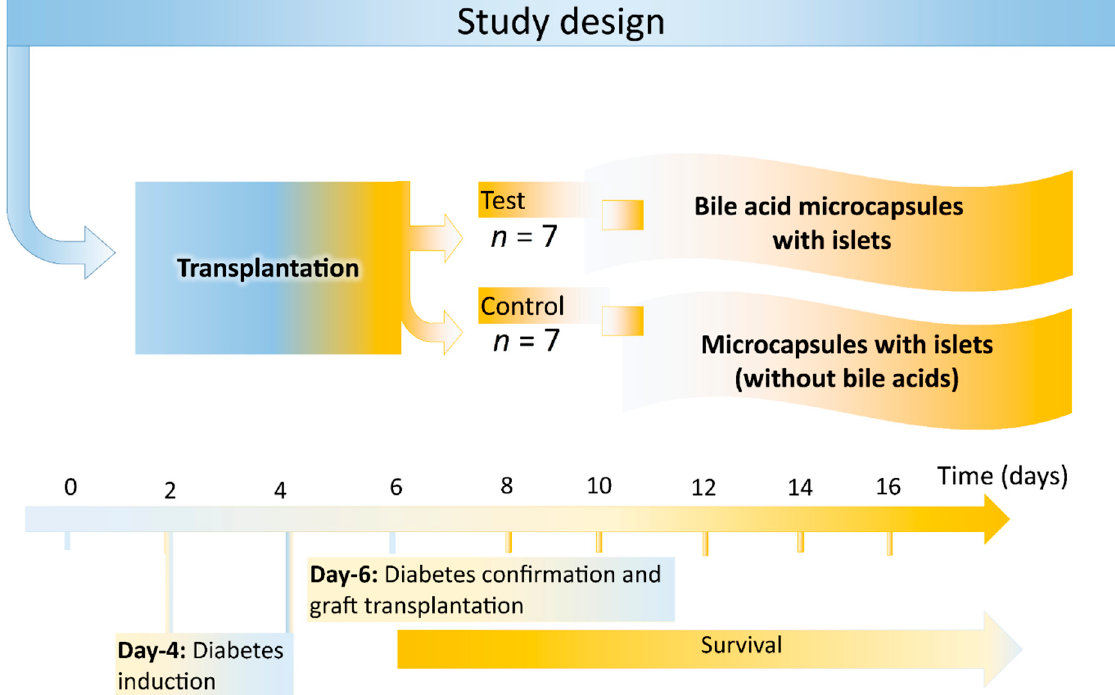
Figure 1. Study design for the transplantation of test (CDCA-PSS-PAA microcapsules with islets) and control (PSS-PAA with islets) in alloxan-induced T1D mice.